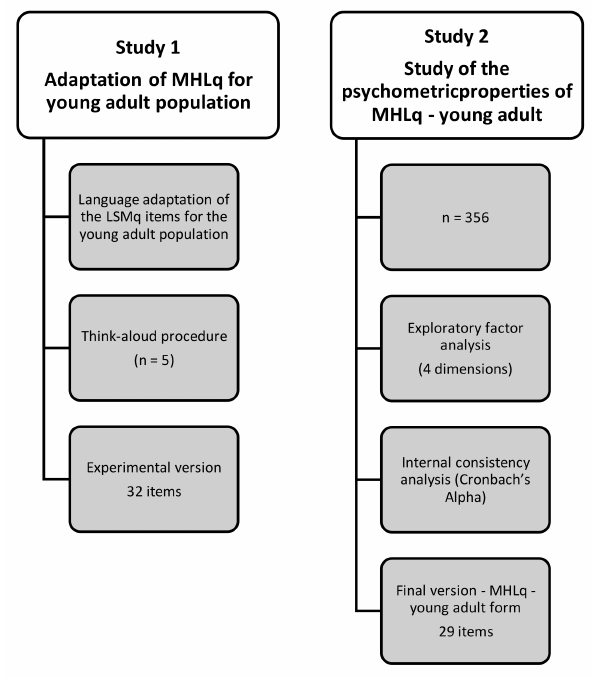
Figure 1. Development of adaptation and study of psychometric properties of the mental health literacy questionnaire (MHLq)-young